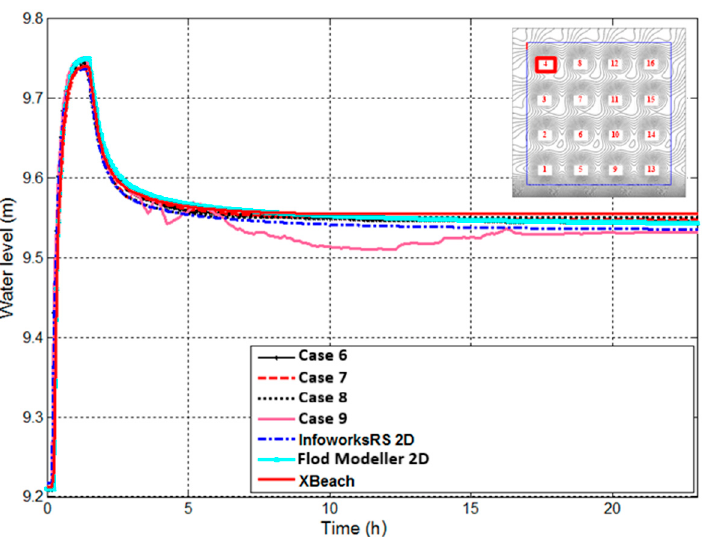
Figure 16. Filling of floodplain depressions: water level results for Depression 4 (closest to inflow boundary).